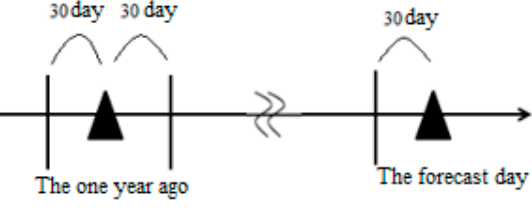
Figure 5. The similar day selection interval [47].